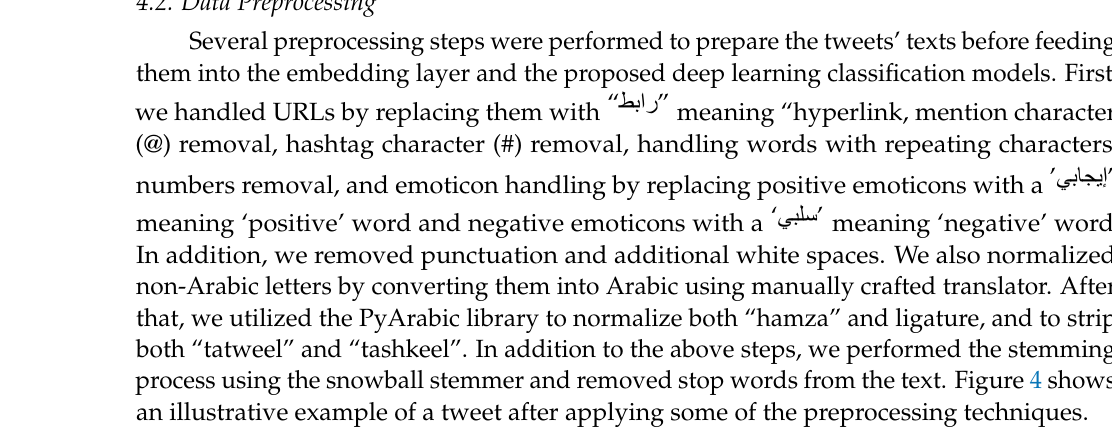
Table 6. Rumor Types and Examples.